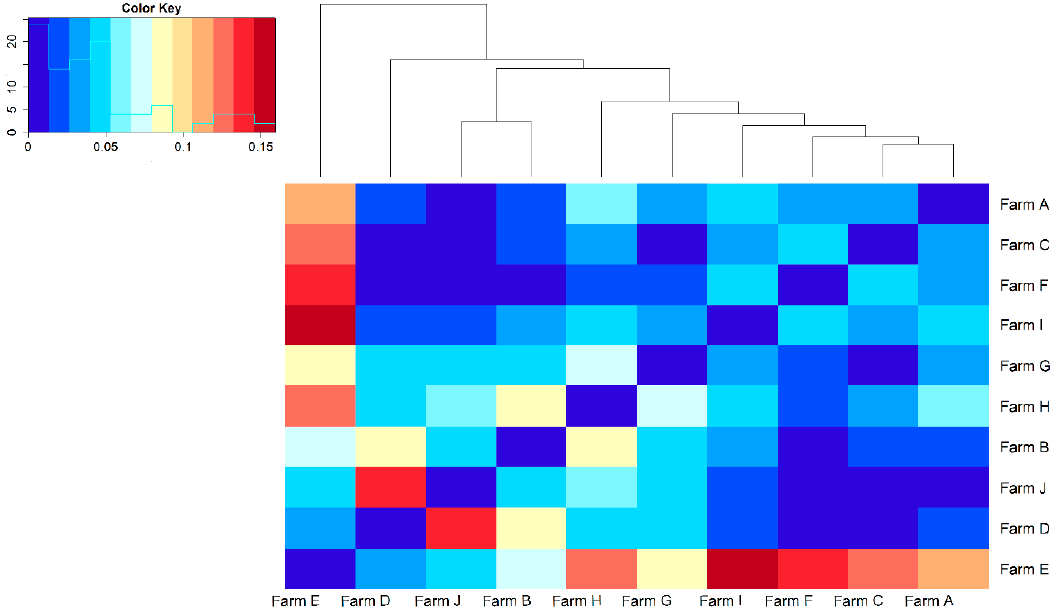
Figure 3. Heatmap of F ST results for the 10 farms found in the reference population (RP). The cells in the plot are colored by Fixation index values with deeper colors indicating higher (red) or lower (blue) genetic distances.